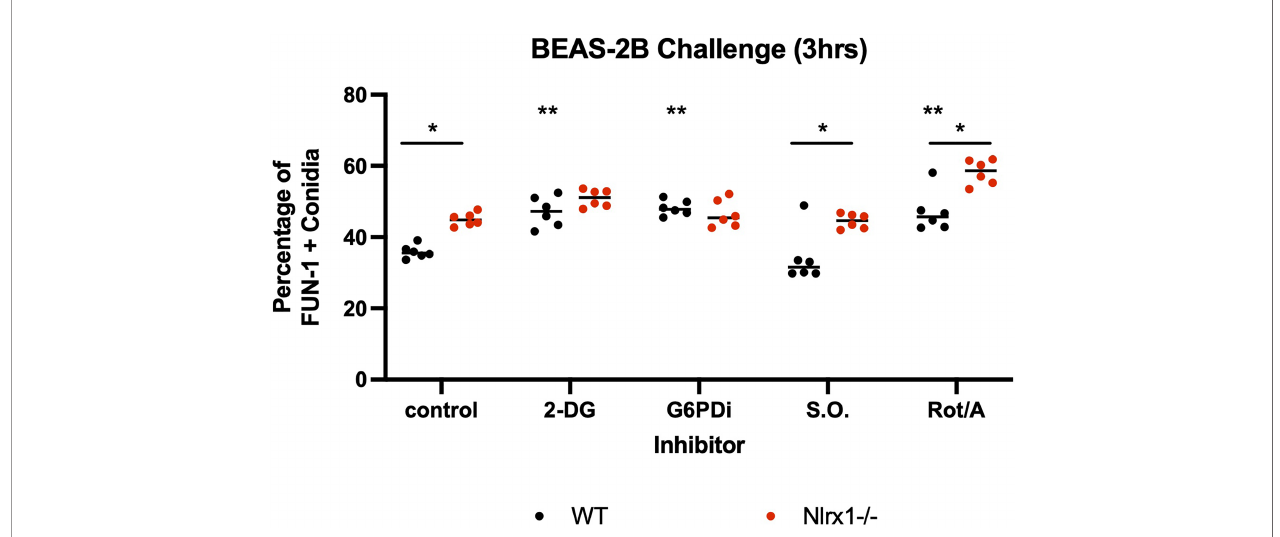
FIGURE 5 | Inhibition of glycolysis and mitochondrial function in BEAS-2B reduces early conidial processing. Wild-type and Nlrx1-de fi cient ( D Nlrx1) BEAS-2B cells were pre-incubated with inhibitors at varying concentrations for 3 h. Cells were then washed three times with 2 × PBS to remove all inhibitors. Cells were then challenged with AF293 for 3 h and a FUN-1+ fl uorescence assay was subsequently conducted. Final concentration of inhibitors: 2-DG, 25 mM; G6PDi-1, 50 m M; Sodium oxamate (S.O.), 25 mM; Rotenone/Antimycin A (Rot/Ant), 0.5 m M. Black double asterisk denotes p < 0.05 via Kruskal – Wallis test followed by a Dunn ’ s test for multiple comparisons against the control. Black single asterisk with a line across the two genotypes denotes p < 0.05 between genotypes for a given treatment